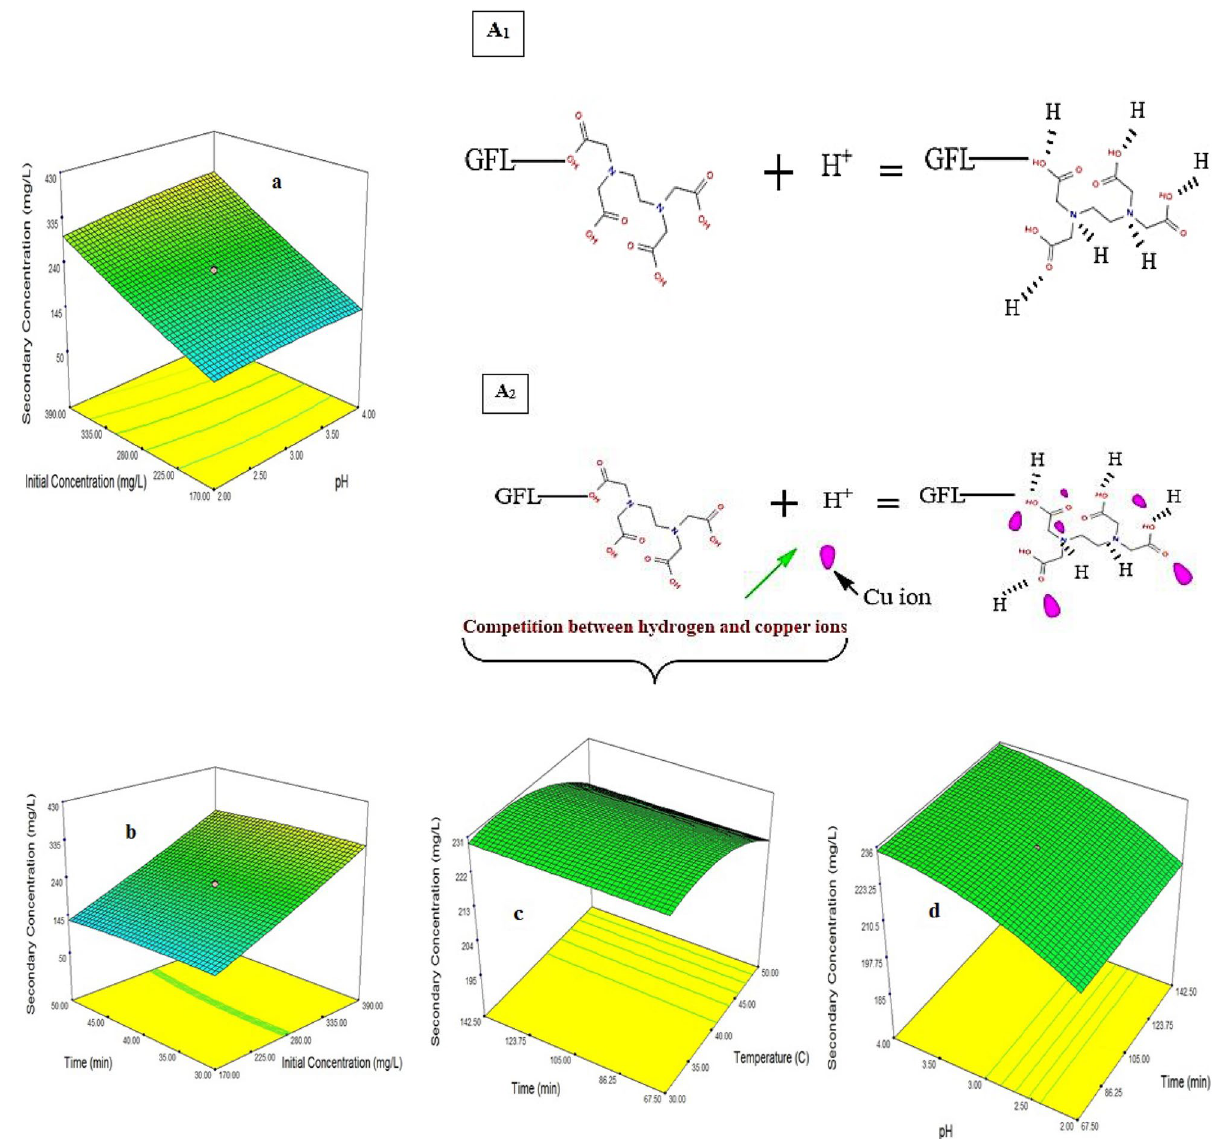
Figure 10. 3D response surface graphs indicating the impacts of mutual interactions between two independent variables A 1 and A 2 process Cu 2+ adsorption on GFLE. The initial concentration of copper Factor (mg L −1